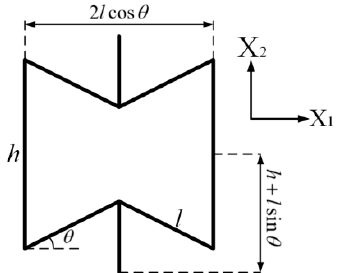
Figure 2. Cell geometry and the coordinate system used for the re-entrant hexagonal honeycomb, where h is the vertical length of the cell member, l is the inclined length of the cell member, and θ is the cell angle.